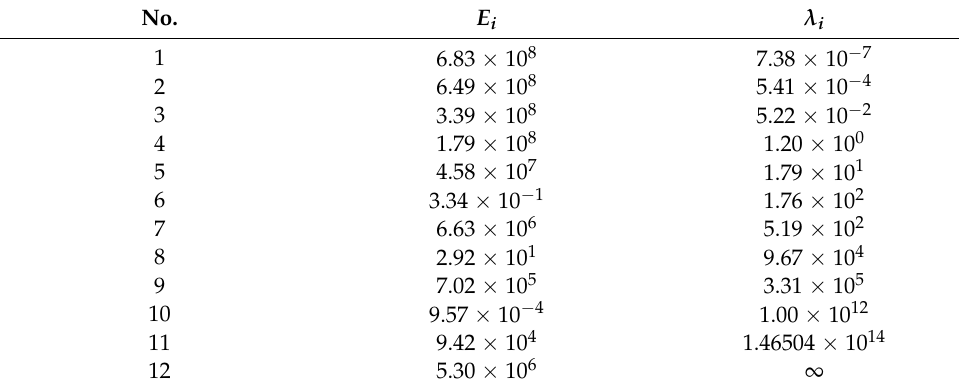
Table 4. E i and λ i for Polymer A.